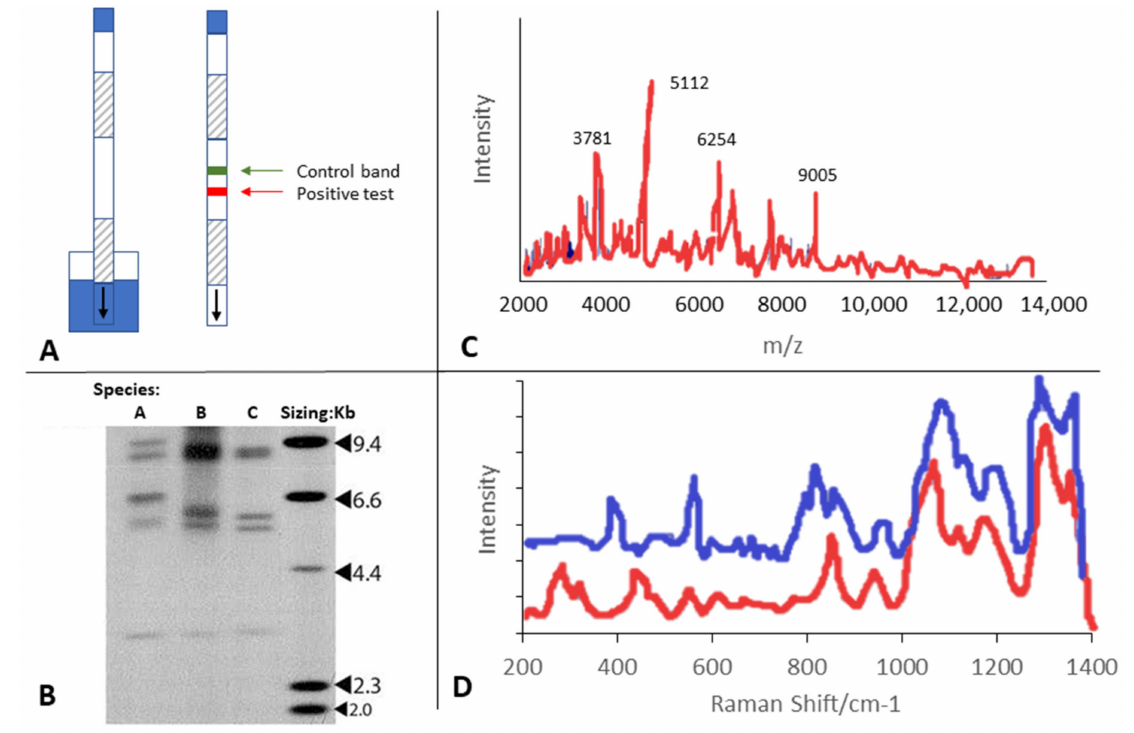
Figure 2. Examples of outputs produced for organism/molecular identification . ( A ) Illustration of Lateral Flow tests trips; ( B ) Example of RFLP output after PCR processing showing 3 samples being processed; ( C ) Digital illustration of MALDI-TOF spectrum output; ( D ) Digital illustration of Raman spectrum output (species 1—red; species